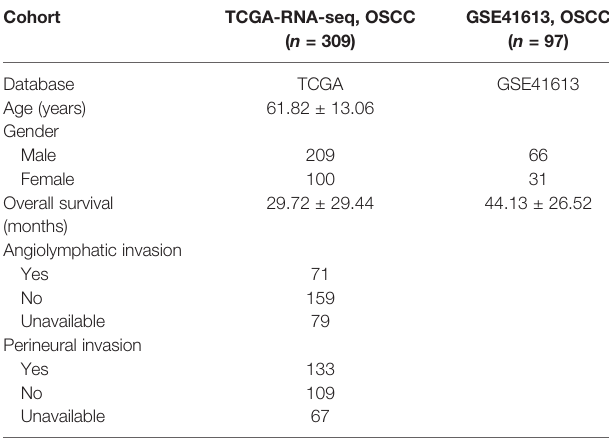
TABLE 1 | Clinical and molecular information included in the